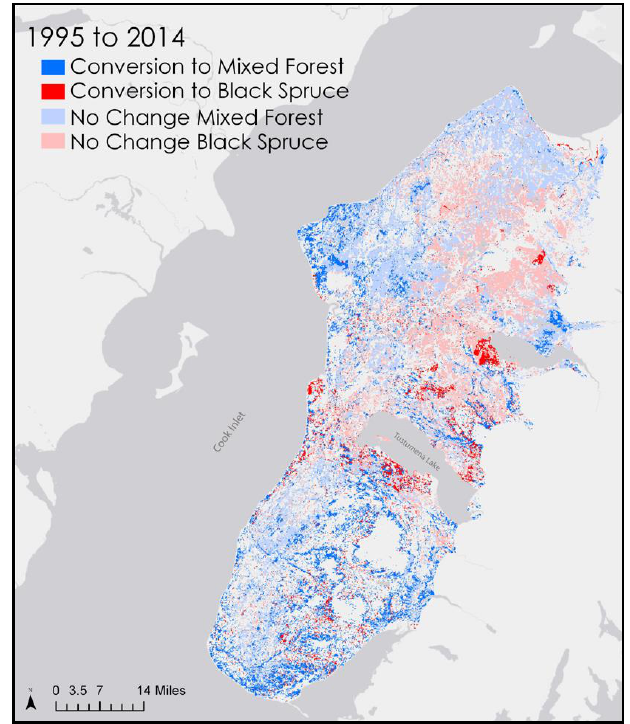
Figure 4. Pixels that changed from other land cover types to forest or remained forested based on classifications of Landsat imagery from 1995 and 2014.